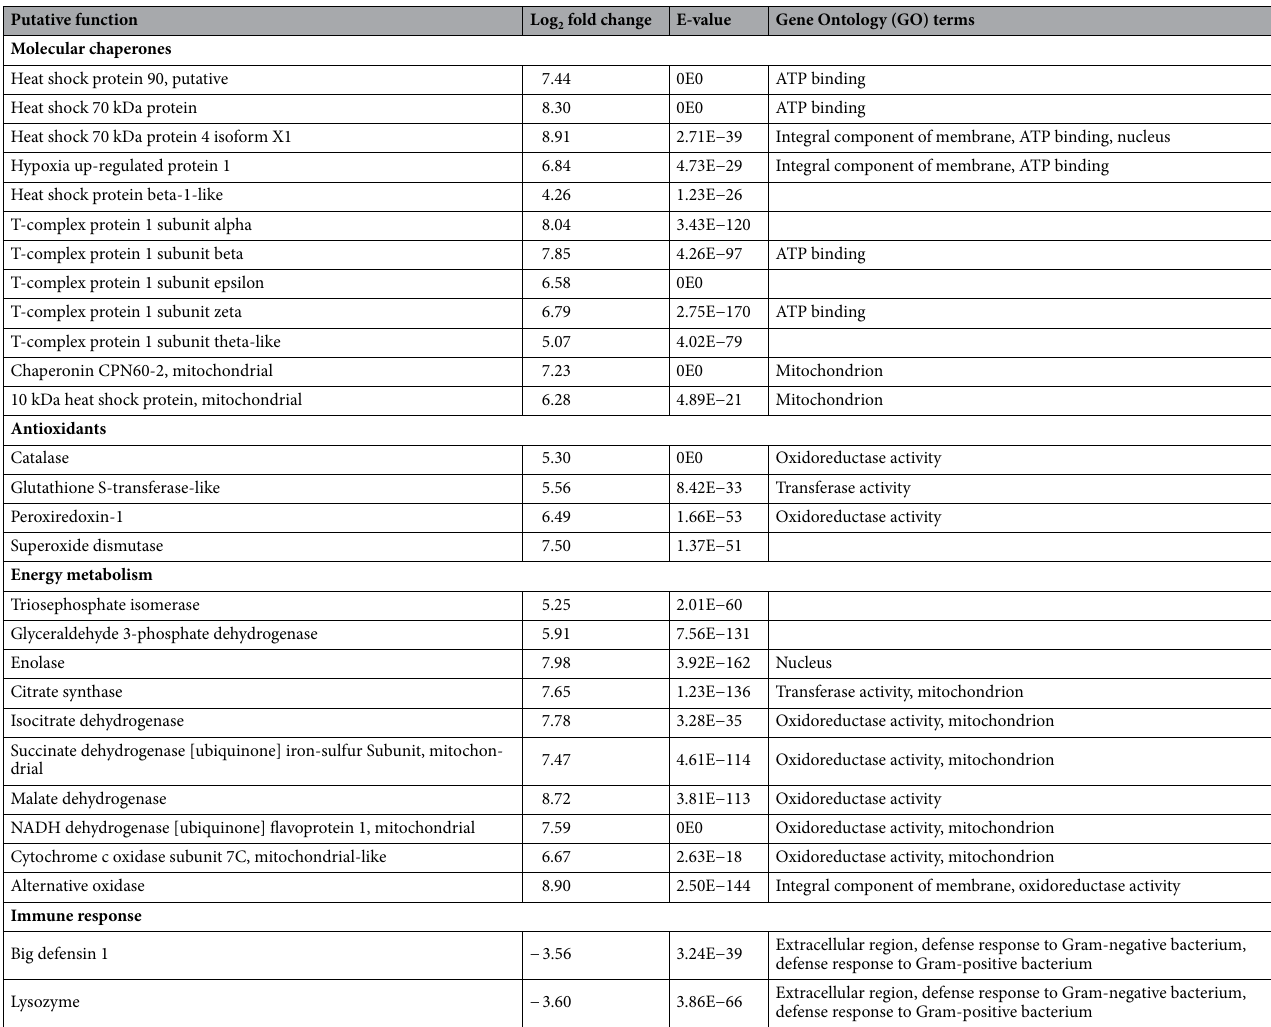
Table 2. Key transcripts differentially expressed in Amblema plicata brought into